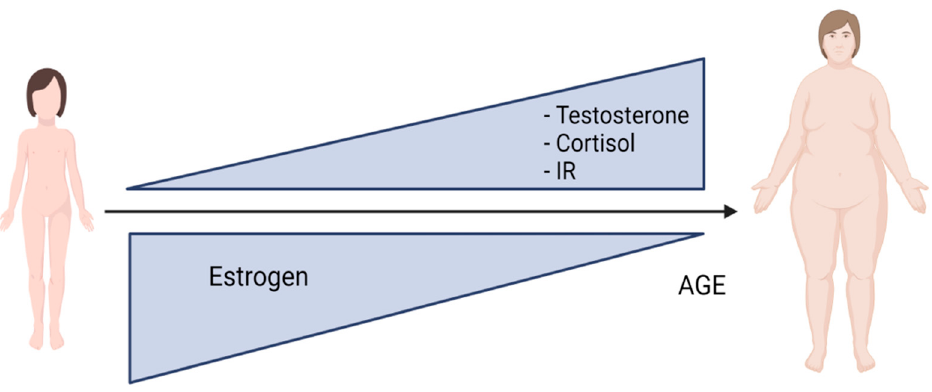
Figure 4. Modulation of hormones in premenopausal stage. During premenopausal stage, sex hormones, such as testosterone and estrogen, undergo an imbalance, together with cortisol, resulting in a dysfunction with a reduction in estrogen and increases in testosterone, cortisol and insulin resistance, resulting in increased body weight and abdominal fat .